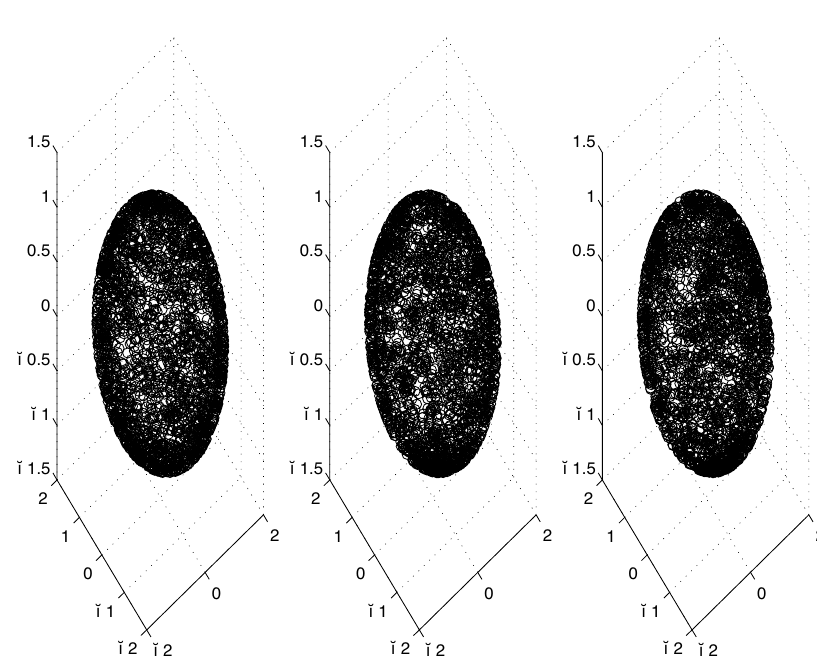
Figure 3: Scatter of perturbed IC 4 with zero mean Gaussian with std 0 . 01 (left), 0 . 1 and 1 (right) persion). Note that four more than five components appear to yield z-scores more concentrated around the border, and thus define a smoother sphere’s surface (see Figure